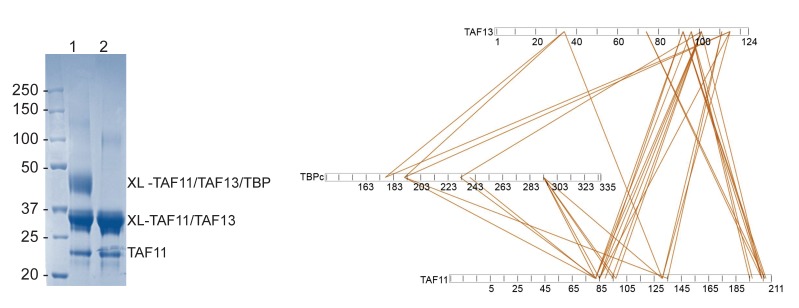
Cross-linking/mass spectrometry (CLMS).TAF11/TAF13/TBP complex and TAF11/TAF13 complex were cross-linked separately using bissulfosuccinimidyl suberate (BS3) and then further purified by SEC using a Superdex 200 10/300 column. Cross-linked and purified TAF11/TAF13/TBP complex (lane 1) and TAF11/TAF13/TBP complex (lane 2) were analyzed by SDS-PAGE (left). The top band corresponds to cross-linked TAF11/TAF13/TBP, the middle band to TAF11/TAF13; the band on the bottom to uncross-linked TAF11. Cross-linked TAF11/TAF13 is present also in the cross-linked TAF11/TAF13/TBP sample. Bands were excised, reduced, alkylated, trypsin digested and desalted followed by mass spectrometric analysis. Cross-links were identified between TAF11 and TAF13, TAF11 and TBP as well as TAF13 and TBP. Cross-links between TAF11-TAF13, TAF11-TBP and TAF13-TBP are shown using 5% FDR cutoff data (right). The N-terminal region of TAF11 is lacking amino acids R and K, and consequently, no cross-links were observed with BS3. Observed cross-links are listed in Table 4.